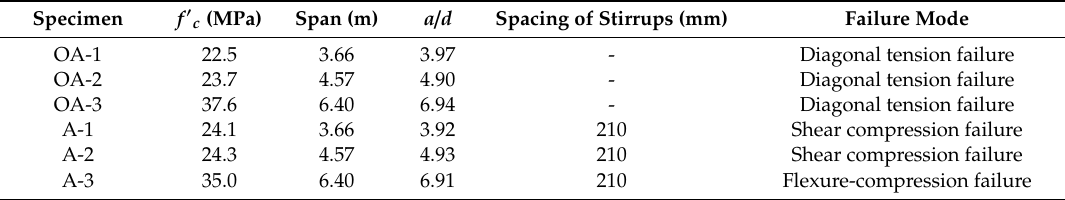
Table 1. Dimensions and material properties of test specimens.